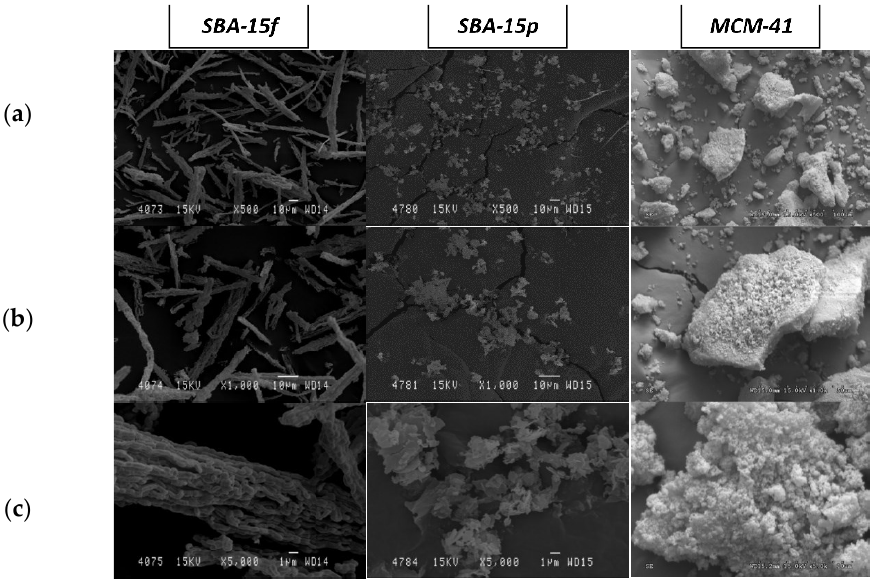
Figure 2. Electron micrographs of the SBA-15f, SBA-15p and MCM-41 at 500 ( a ) , 1000 ( b ) y 5000 ( c )